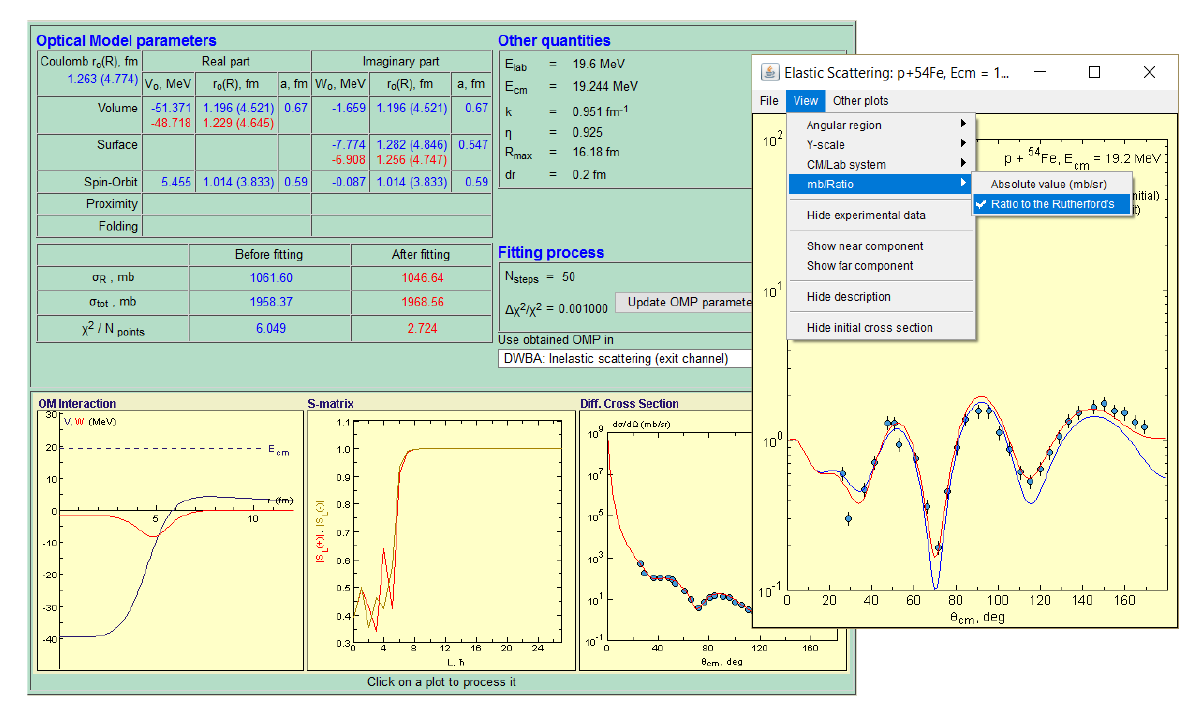
Figure 3. Screenshot of the NRV web page with the results of the Optical Model